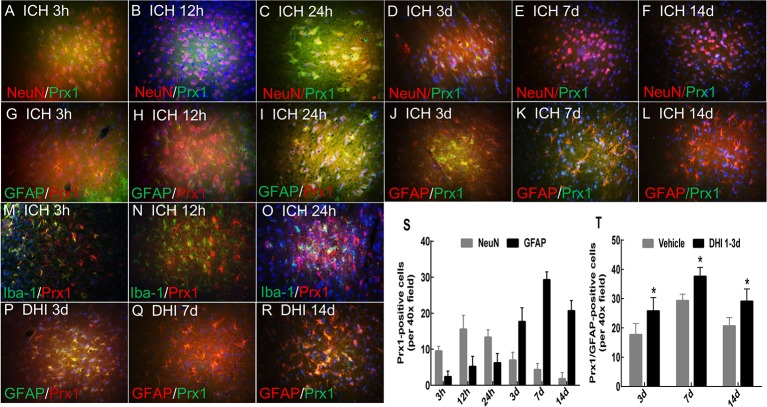
DHI upregulates the Peroxiredoxin 1 (Prx1) expression in astrocytes after ICH. (A–L) The immunofluorescence staining results revealed that Prx1 was mainly expressed in the cytoplasm of neurons within 24 h after ICH, peaked at 12 h, and gradually decreased (A–F). The expression of Prx1 in astrocytes was dramatically increased and peaked on day 7 after ICH (G–L). (M–O) However, no Prx1 was observed in Iba-1+ cells. (P–R) The DHI treatment on days 1–3 after ICH remarkably increased the expression of Prx1 in astrocytes. Majority of Prx1 positive cells were astrocytes. (S) The quantitation of Prx1 expression in neurons and astrocytes after ICH. (T) The quantitation the effect of DHI treatment on days 1–3 after ICH on the Prx1 expression in astrocytes (n = 6, P < 0.05). (Images are shown at 400× magnification, *P < 0.05 vs. vehicle).